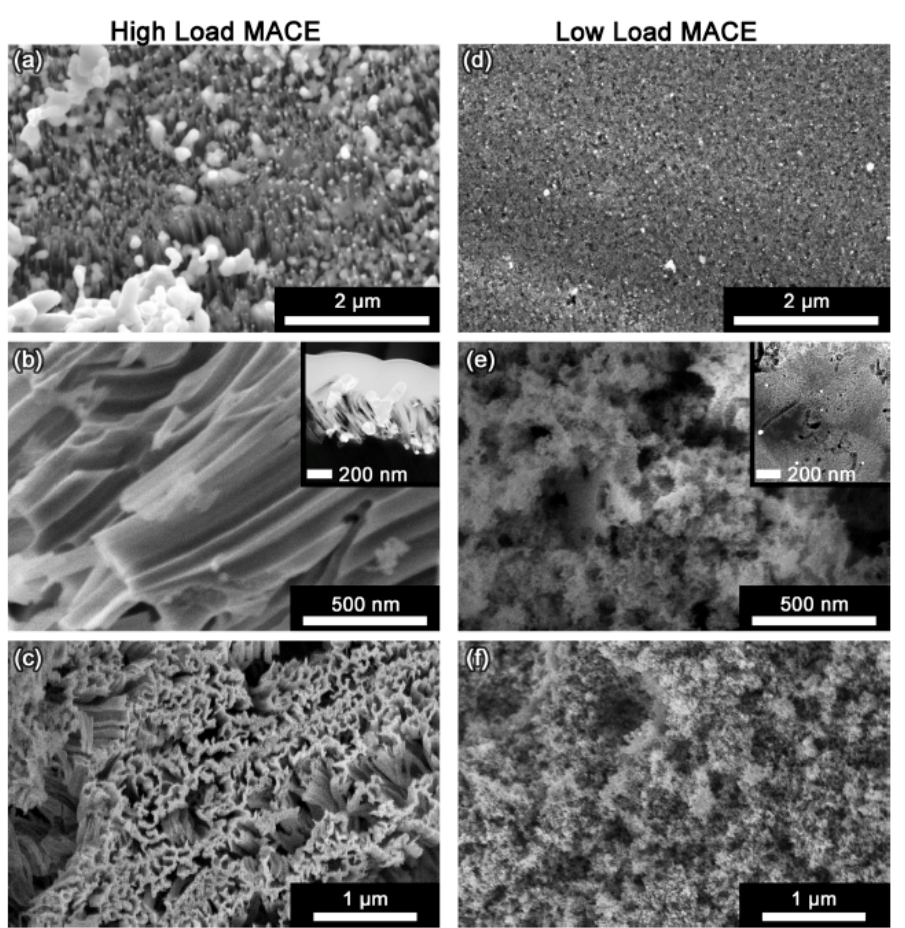
Figure 6. Contrasting structures associated with HL and LL regimes. High-load MACE with Ag (left-hand column) is characterized by: ( a ) Deposition of a thick metal layer composed of dendrites as well as nanoscale and microscale metal particles (plan view); ( b ) etching proceeds with correlated motion of the metal nanoparticles to form predominantly 70–100 nm parallel etch track pores (cross section); ( c ) production of etched silicon particles that are rough in texture and covered with ridges formed by the etch track pores (plan view). Low-load MACE (right-hand column) is characterized by ( d ) light deposition of dispersed individual metal nanoparticles (plan view); ( e ) uncorrelated etching of random 10–50 nm etch track pores that are surrounded by remotely etched 3–6 nm tortuous pores (cross section); ( f ) production of etched particles that are relatively smooth in texture with randomized pores (plan view). Reproduced with permission from Ref. [65]. Copyright © 2020, American Chemical Society.